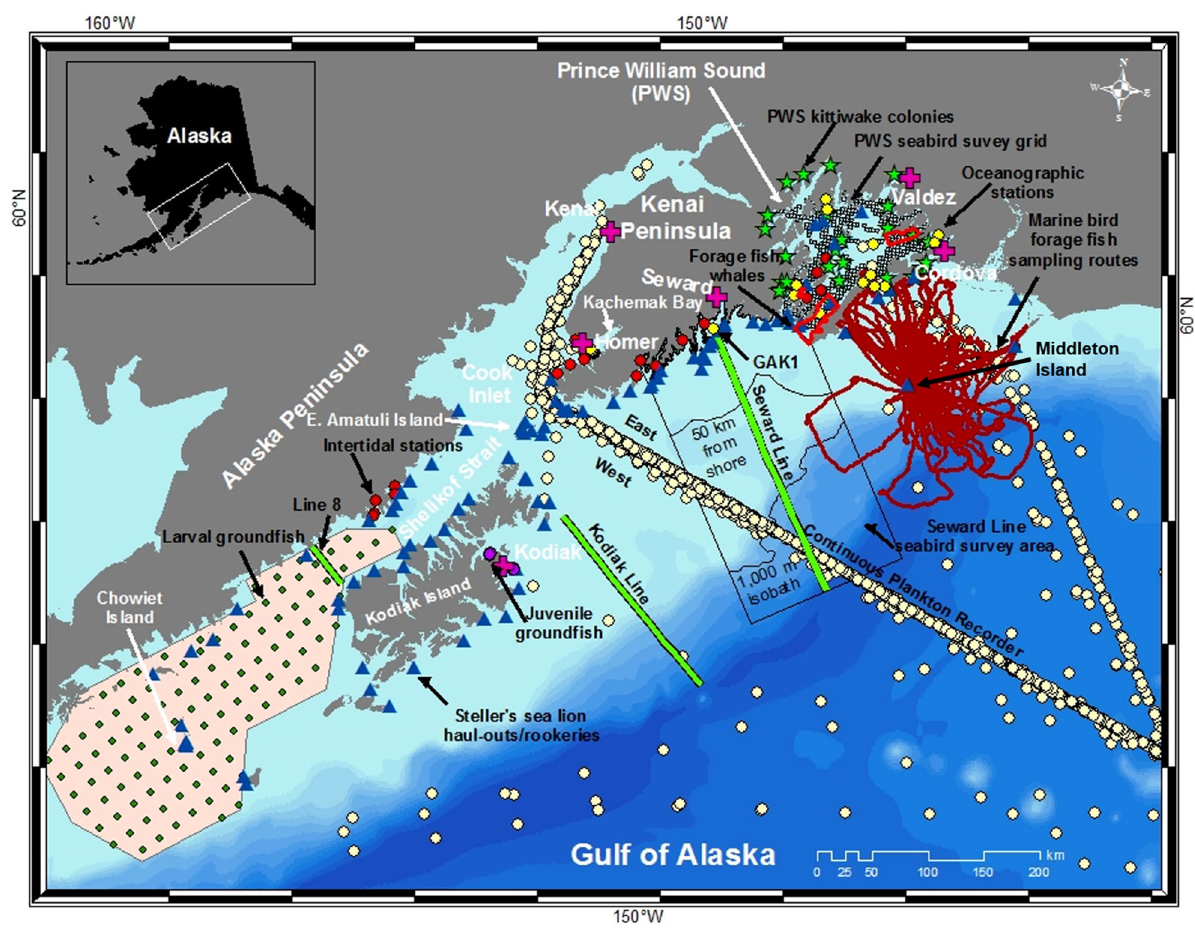
Figure 2. Sampling locations in the northern Gulf of Alaska. The division for references to eastern and western study area is the continuous plankton recorder transect into Cook Inlet. The black contours within the Seward Line marine bird survey area differentiate inner continental shelf (shore to 50 km from shore), middle shelf (50 km from shore to shelf-slope break, defined using 1000 m isobath) and oceanic (seaward of the 1000 m isobath) domains. The 1000 m isobath is also used to distinguish shelf versus oceanic zooplankton samples from the continuous plankton recorder. Marine bird foraging routes provided by Dr. Shannon Whelan, McGill University. This map was created using ArcGIS software (ArcMap 10.7.1; www. esri. com).